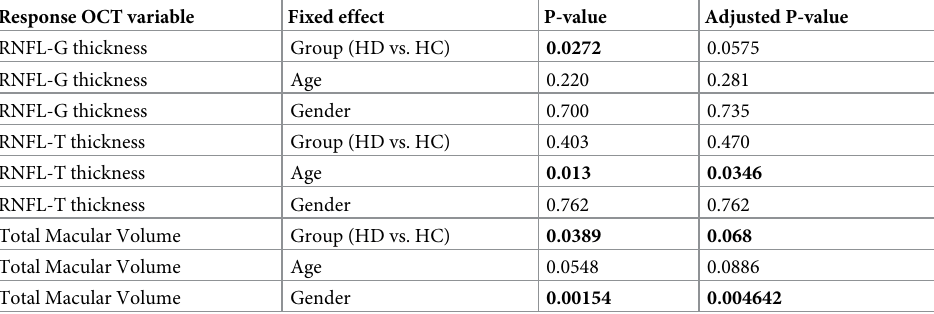
Table 3. Linear mixed effects models for RNFL-G thickness, RNFL-T thickness, and macular volume with group, age and gender as fixed effects.